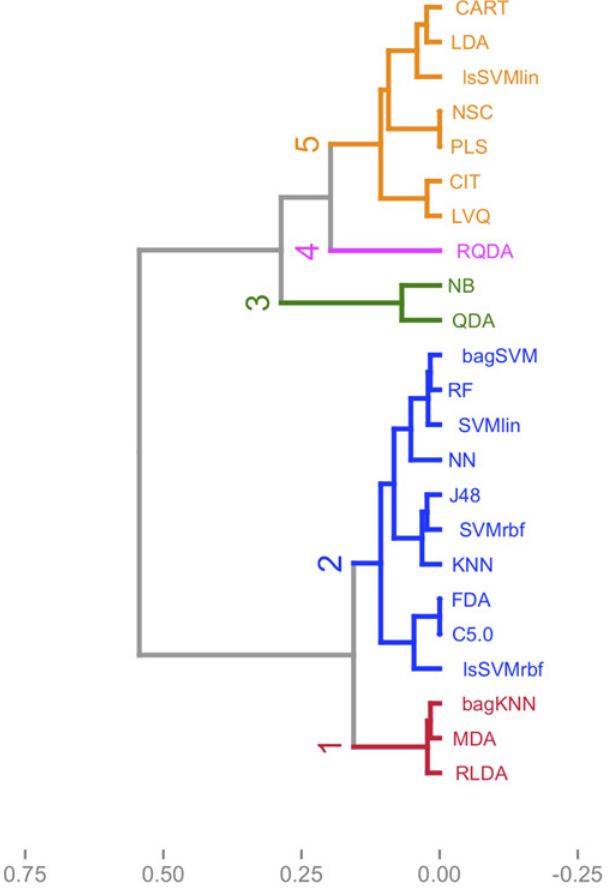
Fig 2. Hierarchical cluster dendrogram. The algorithms used in the study are clustered into five clusters. Cluster 1 and 2 involve the algorithms (RLDA: Robust linear discriminant analysis, bagKNN: Bagged k- nearest neighbors, MDA: Mixture discriminant analysis, KNN: k-Nearest neighbors, SVMrbf: Support vector machines with radial basis function kernel, FDA: Flexible discriminant analysis, J48, C5.0, NN: Neural networks, SVMlin: Support vector machines with linear kernel, lsSVMrbf: Least squares support vector machines with radial basis function kernel, RF: Random forests, bagSVM: Bagged support vector machines), which are loaded on the positive side of the first principal component, and cluster 3 to 5 include the algorithms (LDA: Linear discriminant analysis, lsSVMlin: Least squares support vector machines with linear kernel, NSC: Nearest shrunken centroids, PLS: Partial least squares, QDA: Quadratic discriminant analysis, RQDA: Robust quadratic discriminant analysis, CIT: Conditional inference tree, NB: Na ï ve bayes, LVQ: Learning vector quantization, CART: Classification and regression trees) that are loaded on the negative side of the first principal component.